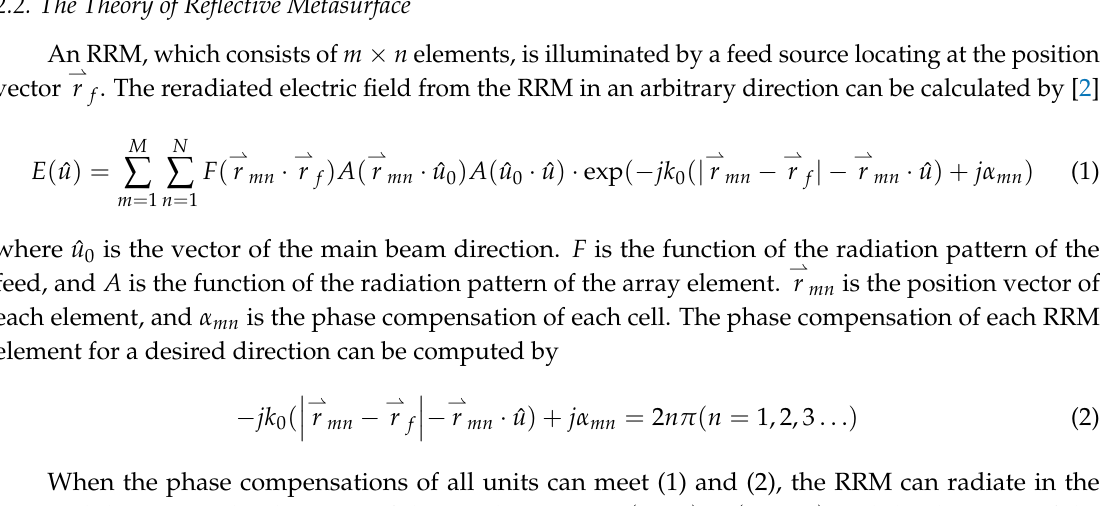
Table 1. Parameters of the 1-bit digital RRM element.